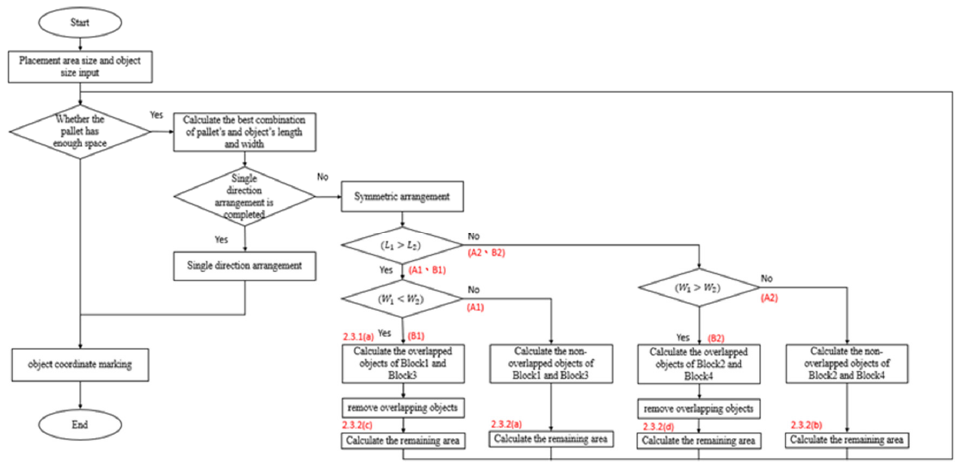
Figure 2. Improved symmetrical arrangement algorithm flow chart.